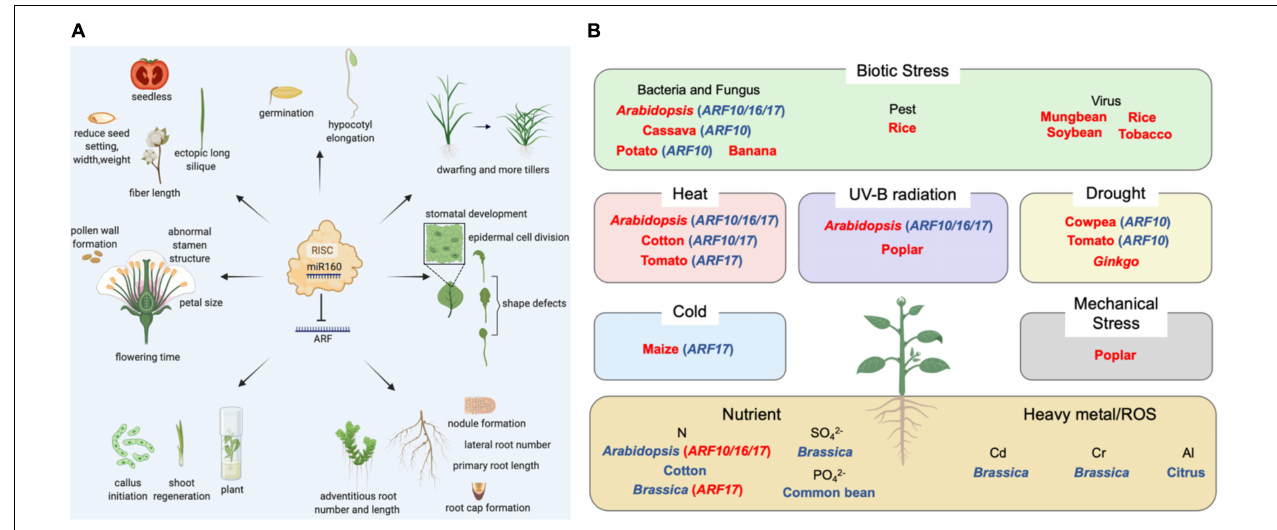
FIGURE 1 | The functions of miR160-ARF module in plants. (A) List of miR160-ARF’s role in various plants during their growth and development. (B) Summary of plant stress responses with miR160 involvement. Blue represents gene down-regulation; red represents gene